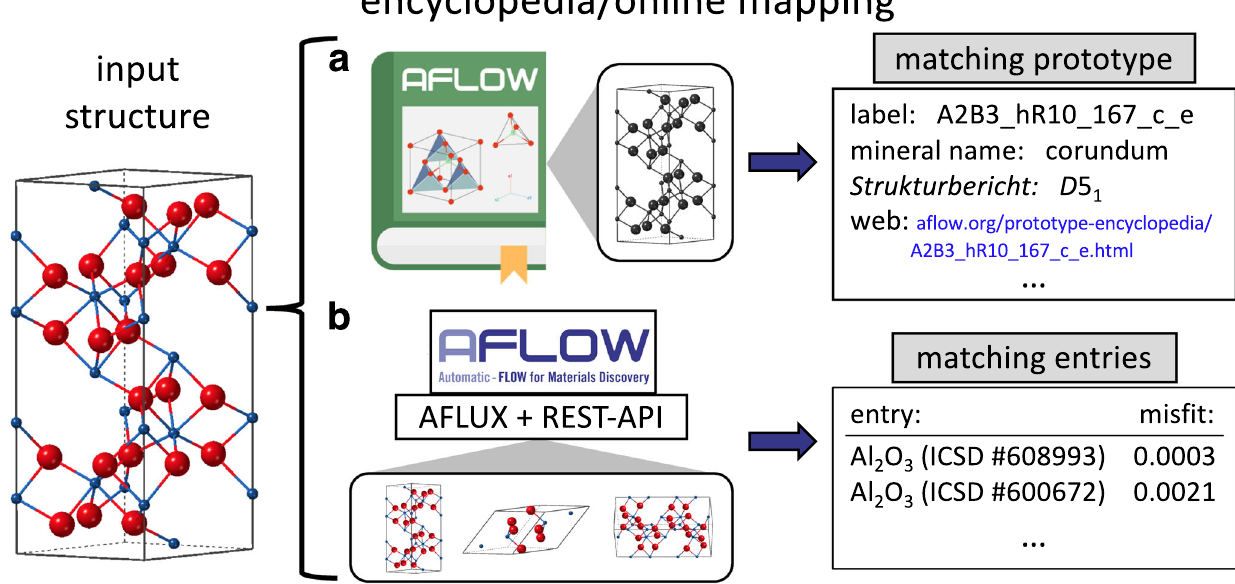
Fig. 5 Encyclopedia/online prototype mapping. An input Al 2 O 3 (corundum) compound is compared to entries in a AFLOW Prototype Encyclopedia and b the AFLOW.org repository. Potential equivalent entries are retrieved automatically from the respective catalog and compared with XtalFinder. Matching entries and their level of similarity (mis fi t) are